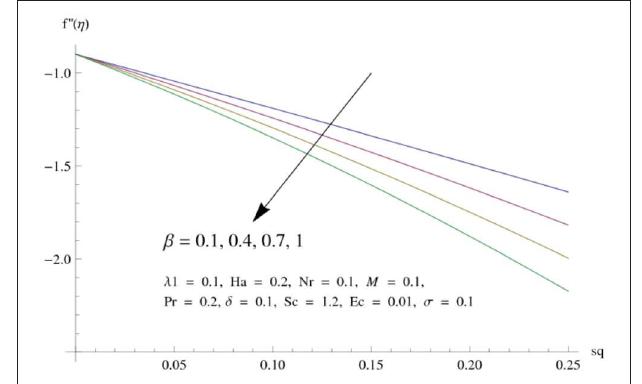
FIGURE 13 | Behavior of S q & β on Cf .